Question: Provide a one-line summary of what is displayed.
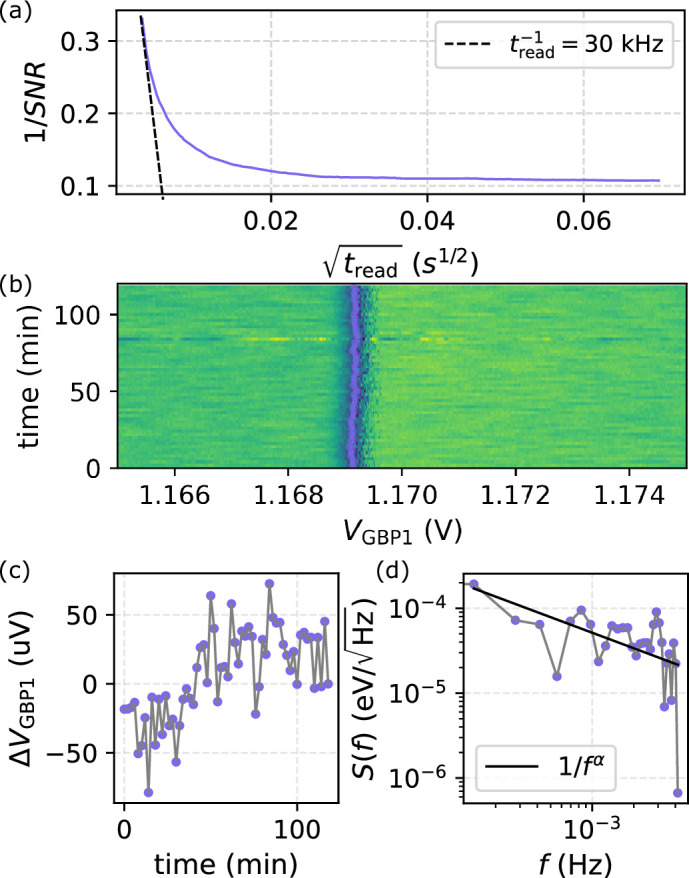
Answer: Noise analysis. ( a ) Fast noise: at fixed signal 1/SNR = σ is suppressed linearly with \documentclass[12pt]{minimal} \usepackage{amsmath} \usepackage{wasysym} \usepackage{amsfonts} \usepackage{amssymb} \usepackage{amsbsy} \usepackage{mathrsfs} \usepackage{upgreek} \setlength{\oddsidemargin}{-69pt} \begin{document}$$1/\sqrt{{t}_{{\rm{read}}}}$$\end{document} 1 / t read up until it plateau for \documentclass[12pt]{minimal} \usepackage{amsmath} \usepackage{wasysym} \usepackage{amsfonts} \usepackage{amssymb} \usepackage{amsbsy} \usepackage{mathrsfs} \usepackage{upgreek} \setlength{\oddsidemargin}{-69pt} \begin{document}$${t}_{{\rm{read}}}^{-1} \sim 30$$\end{document} t read - 1 ~ 30 kHz. This is where non-white noise such as charge noise starts to dominate. ( b ) Stability of the SEB: peak tracking of the SEB point with centre obtained from fit to c o s h −2 . ( c ) Slow noise : noise spectral density calculated from welch method and using gate lever-arm α g = 0.14. Fit to S ( f ) = A / f α with α = 0.6 ± 0.2 and A = 0.8 ± 1 × 10 −6 (95% CI).